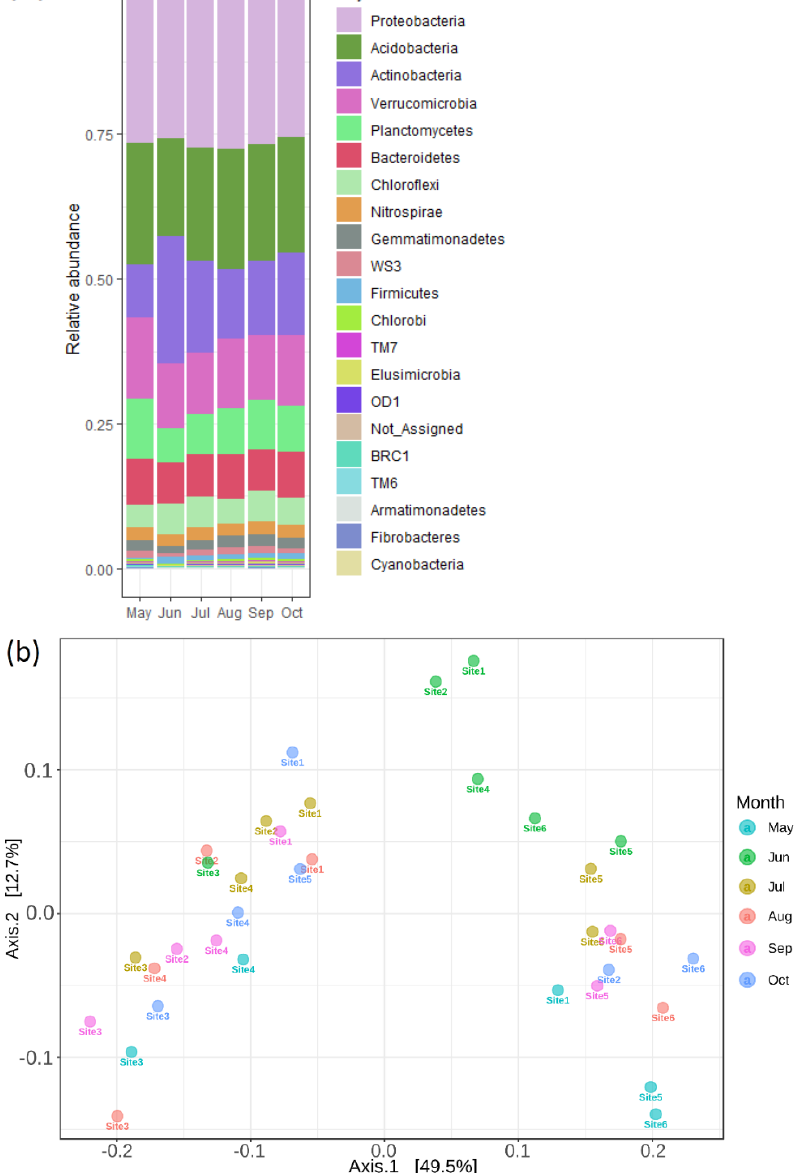
Figure 6. Bacterial community remains unchanged over seasons. ( a ) Stacked bar chart across the growing seasons; ( b ) PCoA showing beta-diversity using Bray–Curtis distance [PERMANOVA] F-value: 1.2403; R-squared: 0.17617; p -value < 0.217.